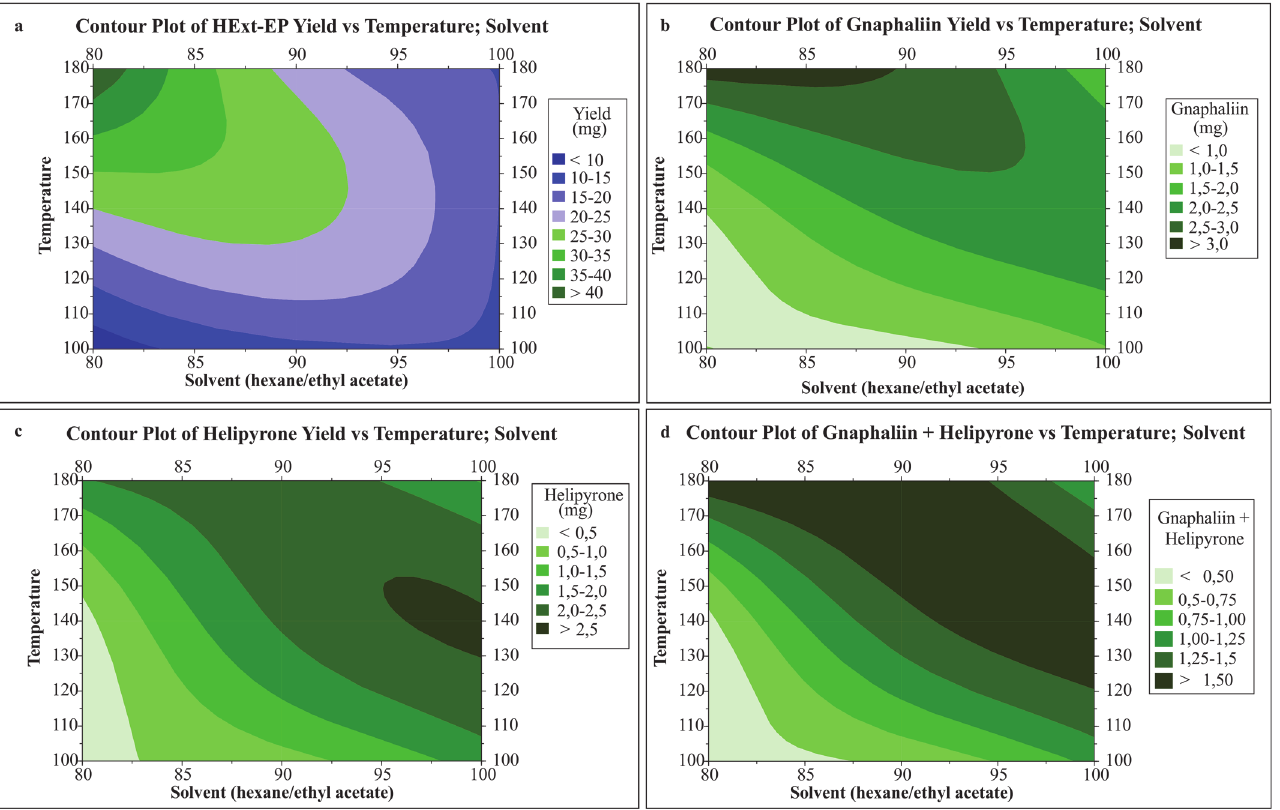
Fig 3. Contour plot of responses analysied on during the RSM experiment for HExt-EP yield (A), Gnaphaliin yield (B), Helipyrone yield (C) and the sum of gnaphaliin and helipyrone (D).